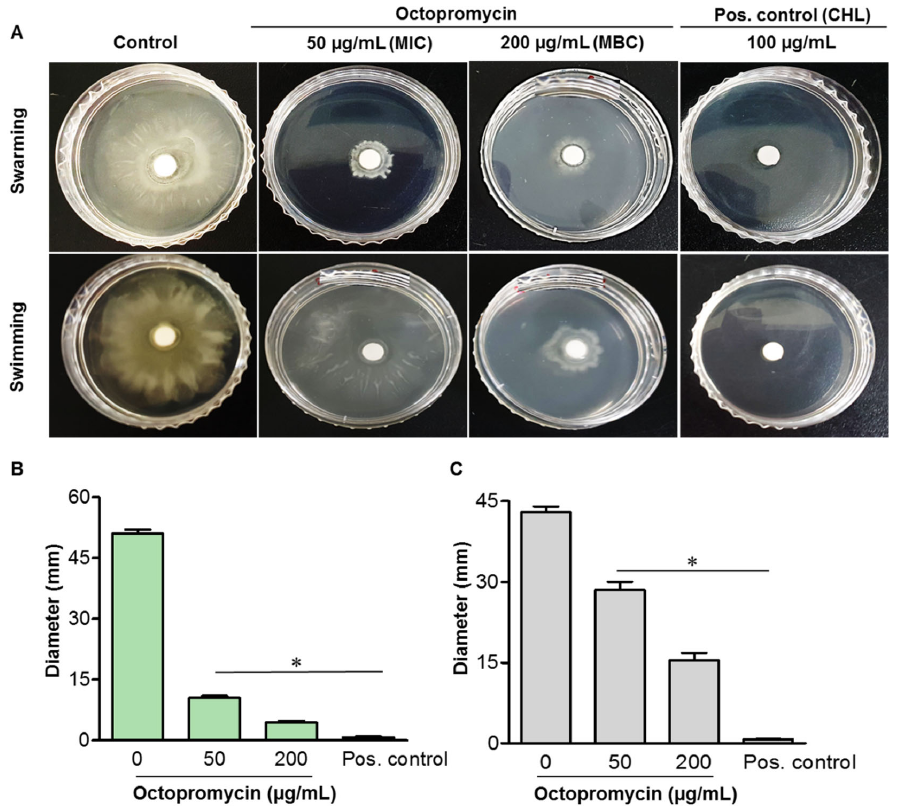
Figure 4. Effect of octopromycin on swarming and swimming motility of A. baumannii . Plates were point ‐ inoculated from overnight cultures. Images were taken after 20 h of incubation at 25 °C. ( A ) Swarming and swimming bacteria circles in the presence of octopromycin MIC (50 μ g/mL) and MBC (200 μ g/mL). Diameter of the ( B ) swarming and ( C ) swimming bacteria circles. Positive (Pos.) control; CHL (100 μ g/mL). * p ≤ 0.05 compared to the control (untreated) group. The error bars indicate means ± standard deviation ( n = 3).